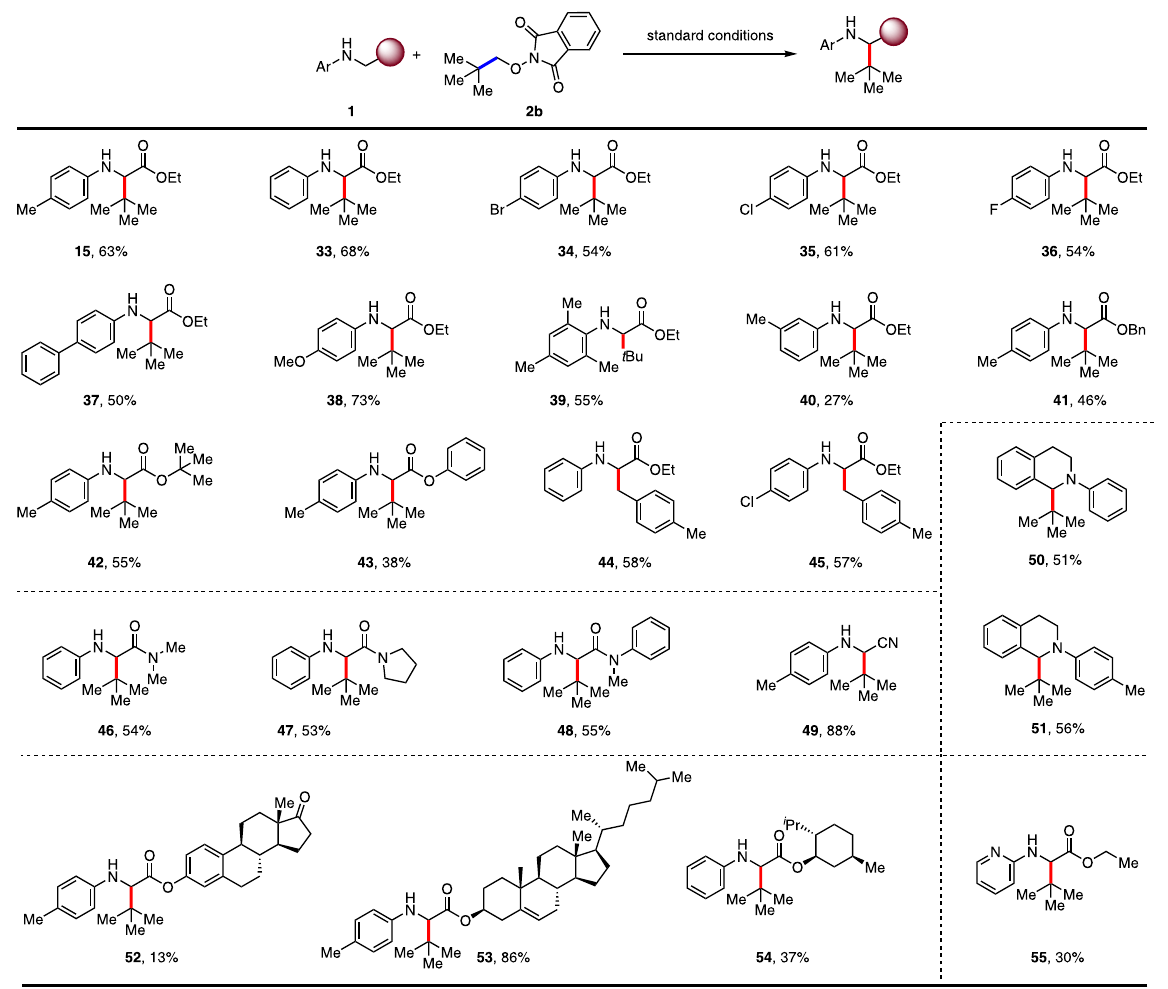
Fig.4|Scopeof N -arylprotectedderivatives. Conditions:Allreactionswerecarriedoutwith4CzIPN(5mol%), 1 (0.2mmol), 2b (0.1mmol),andDMSO(0.03M)irradiated under 15W Blue LEDs at 60°C.